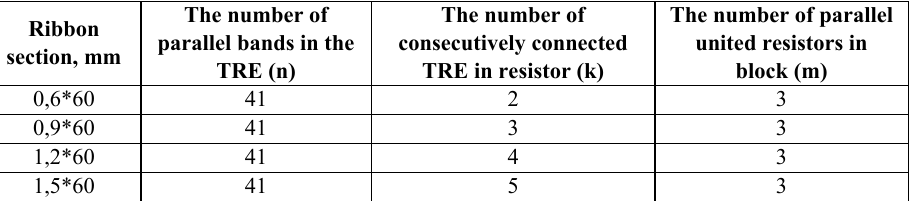
Table 1. Configuration of brake resistor